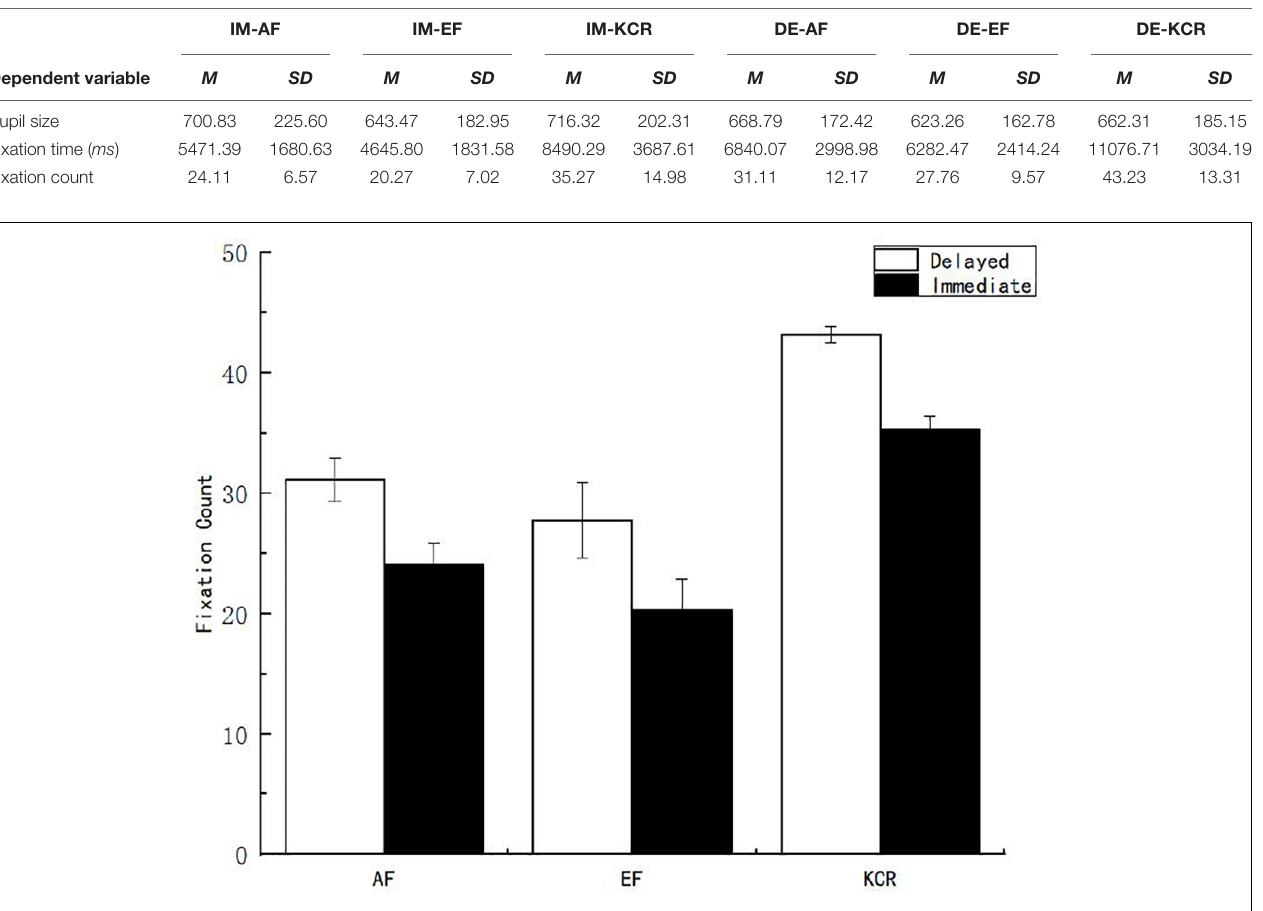
FIGURE 5 | Fixation count of learners on the interest area of the stem under different feedback